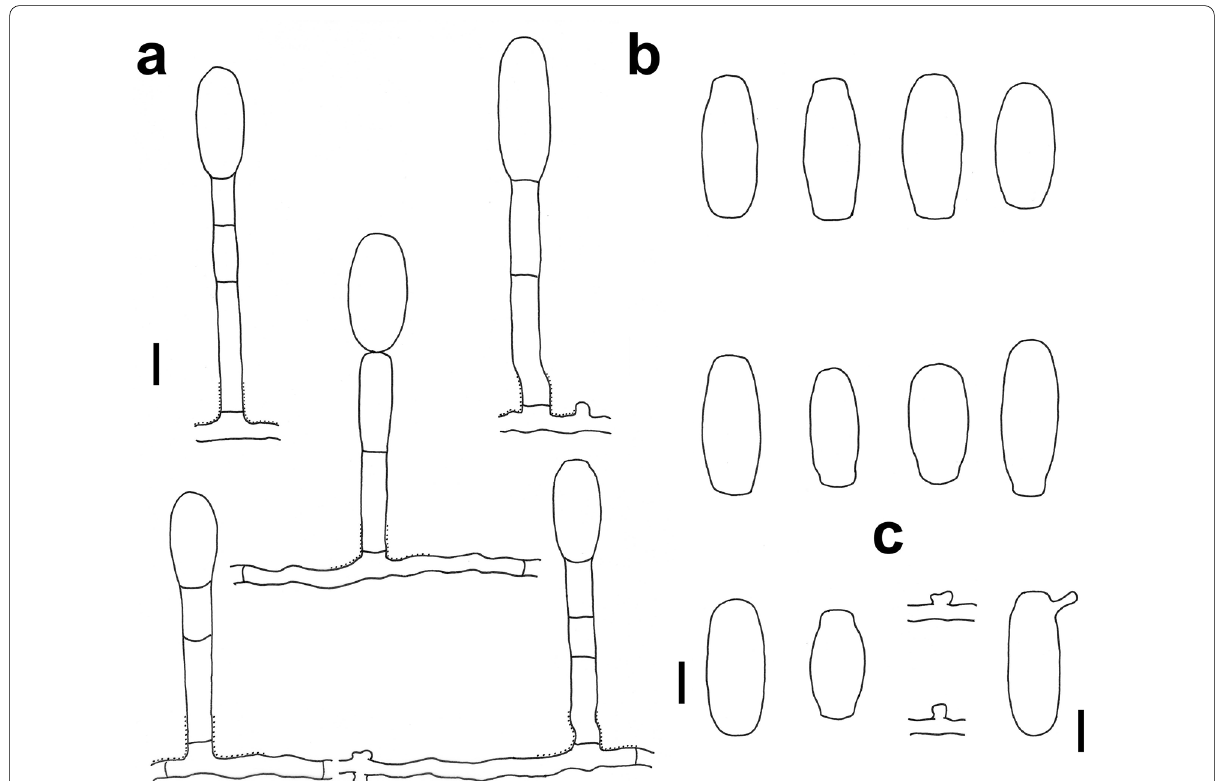
Fig. 6 Erysiphe lespedezae on Desmodium caudatum (R. Kirschner 4646). a Hyphae with lobed appressoria and conidiophores. b Conidia. c Conidia with germination hyphae and